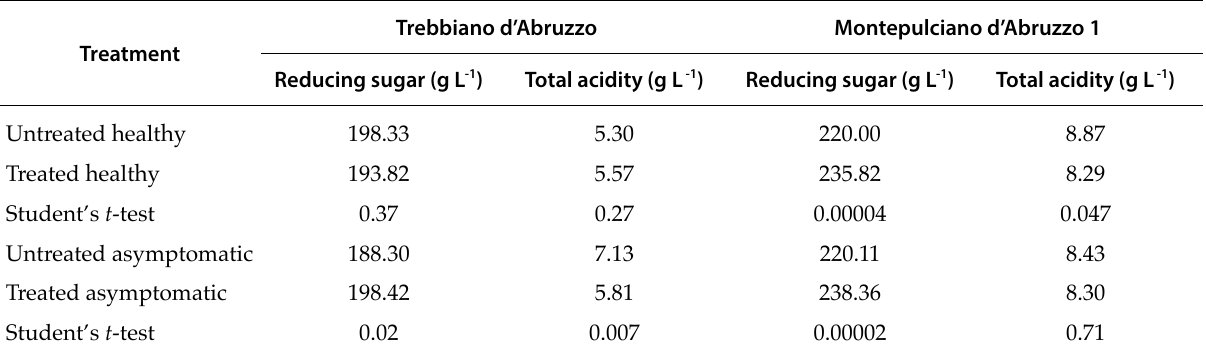
Table 6. Reducing sugar and total acidity in berries of vines treated with the full mixture CaCl extract and untreated vines in the Trebbiano d’Abruzzo and Montepulciano d’Abruzzo 1 vineyards in 2012. Data were compared by the Student t -test ( P ≤0.05).